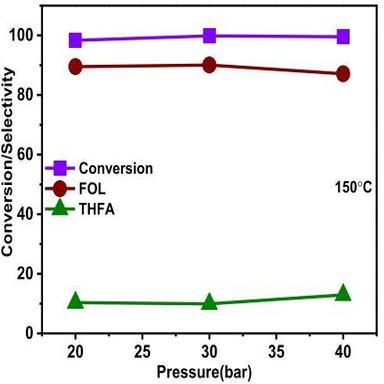
Effect of variation of H2 pressure on conversion/selectivity.